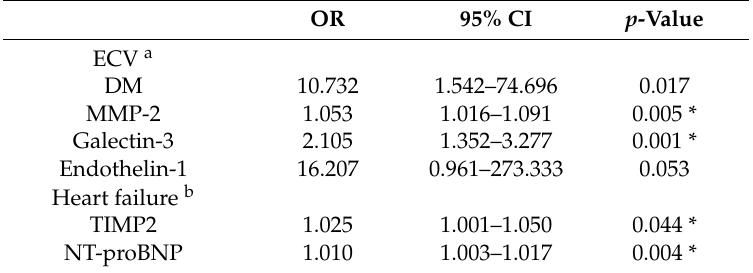
Table 2. Logistic regression analysis demonstrating the determinants of ECV and heart failure.